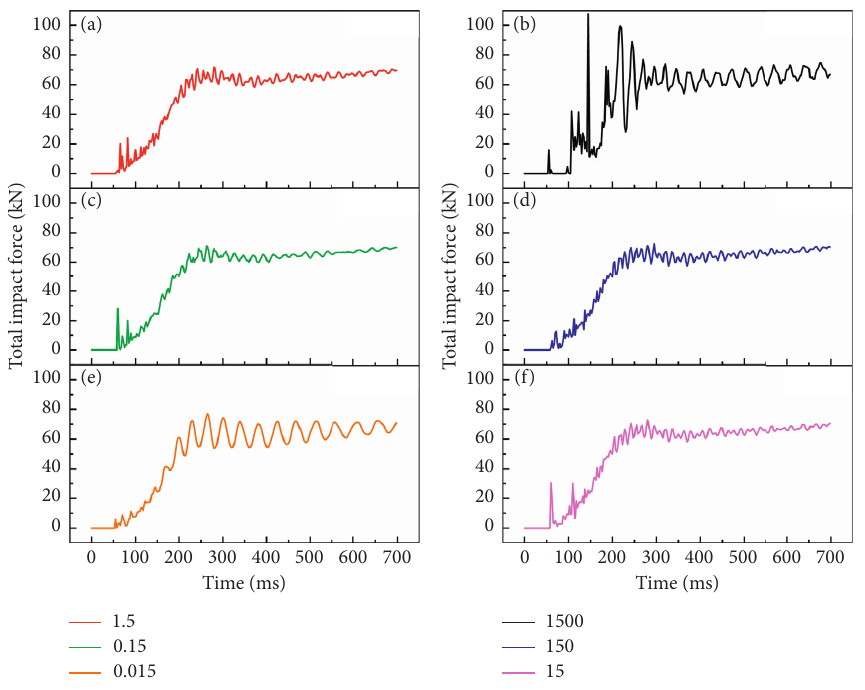
A splash-up and an upward-moving jet were formed; a large amount of Figure 2 (f) floodwater accumulated inside the building; there was merely slight damage or even no damage to the structure. A significant splash-up and an upward-moving jet were seen; all first-floor Figure 2 (c) and masonry walls orthogonal to the flow direction were almost destroyed; the 2 (e) building did not collapse. The physical phenomenon was similar to the “moderate damage” case; more Figure 2 (b) load-bearing components were damaged; no building collapse was observed. An upward-moving jet was seen; the brittle failure occurred and led to the forward collapse of the whole building. A high-speed oblique-moving jet flow impacted the roof; bending failure (the Figure 2 (d) roof), three-plastic-hinge bending failure (the 1st-row columns), and two- plastic-hinge bending failure (the 2nd-row and the 3rd-row columns) were observed; the entire building was